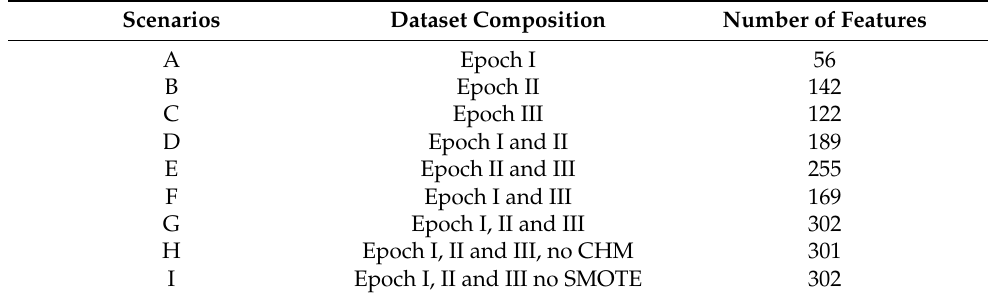
Table 7. The evaluated scenarios. Epoch-independent features (second-order texture and elevation) are included in feature